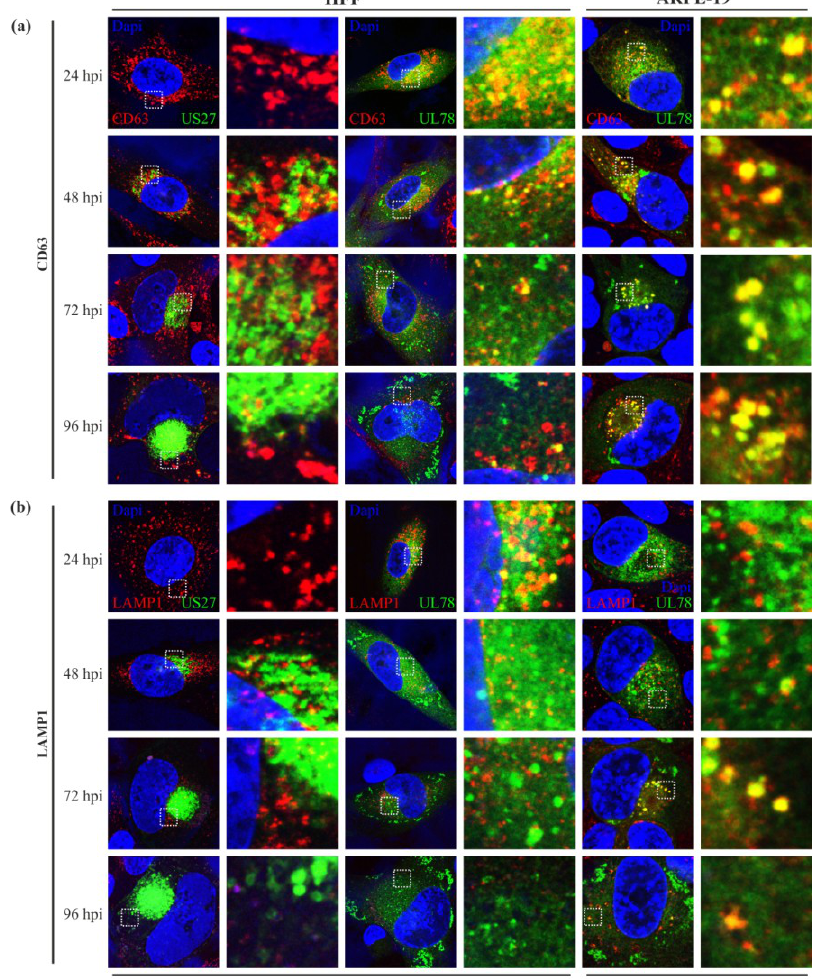
Figure 6. CD63 and LAMP1 staining of US27-EYFP and UL78-EYFP infected HFFs and ARPE-19. HFF (left and middle panel) or ARPE-19 cells (right panel) were infected with recombinant TB40/E viruses (MOI: 0.5 or 1) expressing fusion proteins of pUS27 (left panel) or pUL78 (middle and right panel) with EYFP and fixed at different time points during HCMV infection (24–96 hpi). Cells were stained with primary antibody ( a ) mAb-CD63 (MX-49.129.5) or ( b ) mAb-LAMP-1 (H5G11), each diluted 1:50, and the secondary anti-mouse antibody coupled to Alexa-555 (1:400). Cell nuclei were stained with